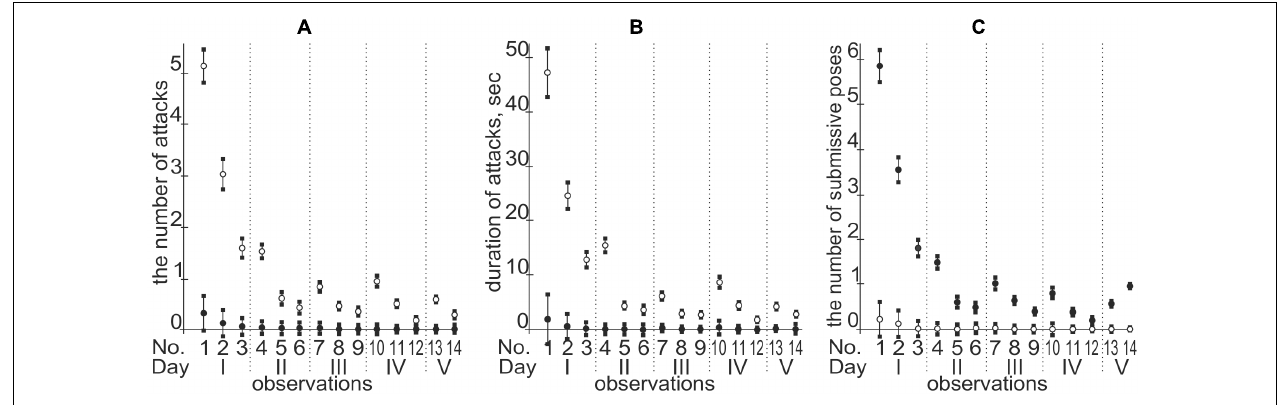
FIGURE 4 | A temporal pattern of both formation and maintenance of the social hierarchy in mouse pairs. Legend: ◦ and • , dominant and subordinate male mice, respectively; (A) the number of attacks; (B) duration of attacks (second); (C) the number of submissive poses; the circle and error bar denote the arithmetic mean and SD for 115 observations,